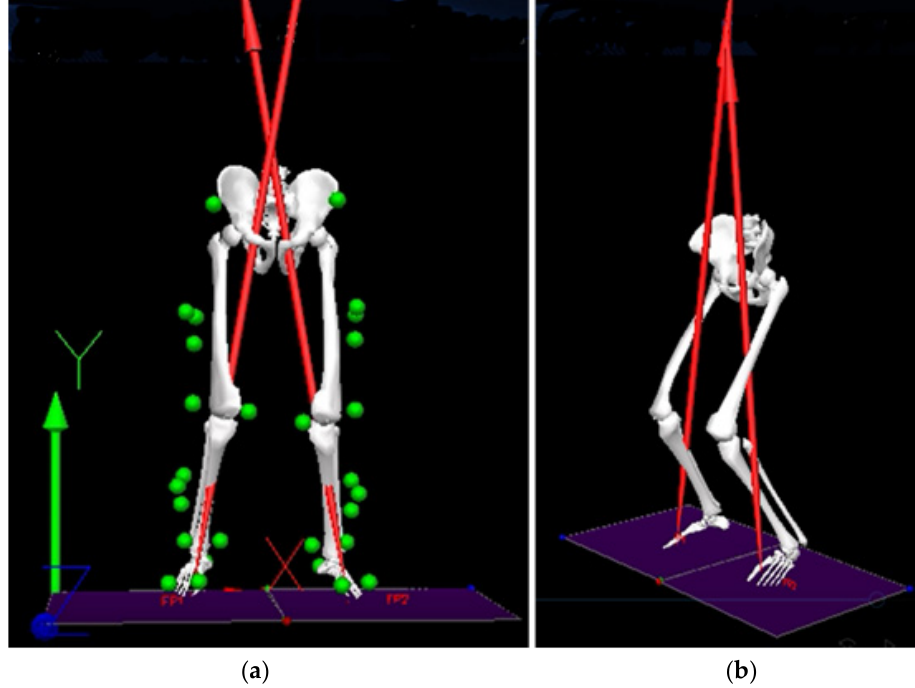
Figure 3. First landing phase of the Vertical Drop Jump in Visual3D, frontal ( a ) and lateral ( b ) views. The green spheres represent the markers on the anatomical landmarks whilst the red arrows are the vertical GRFs.